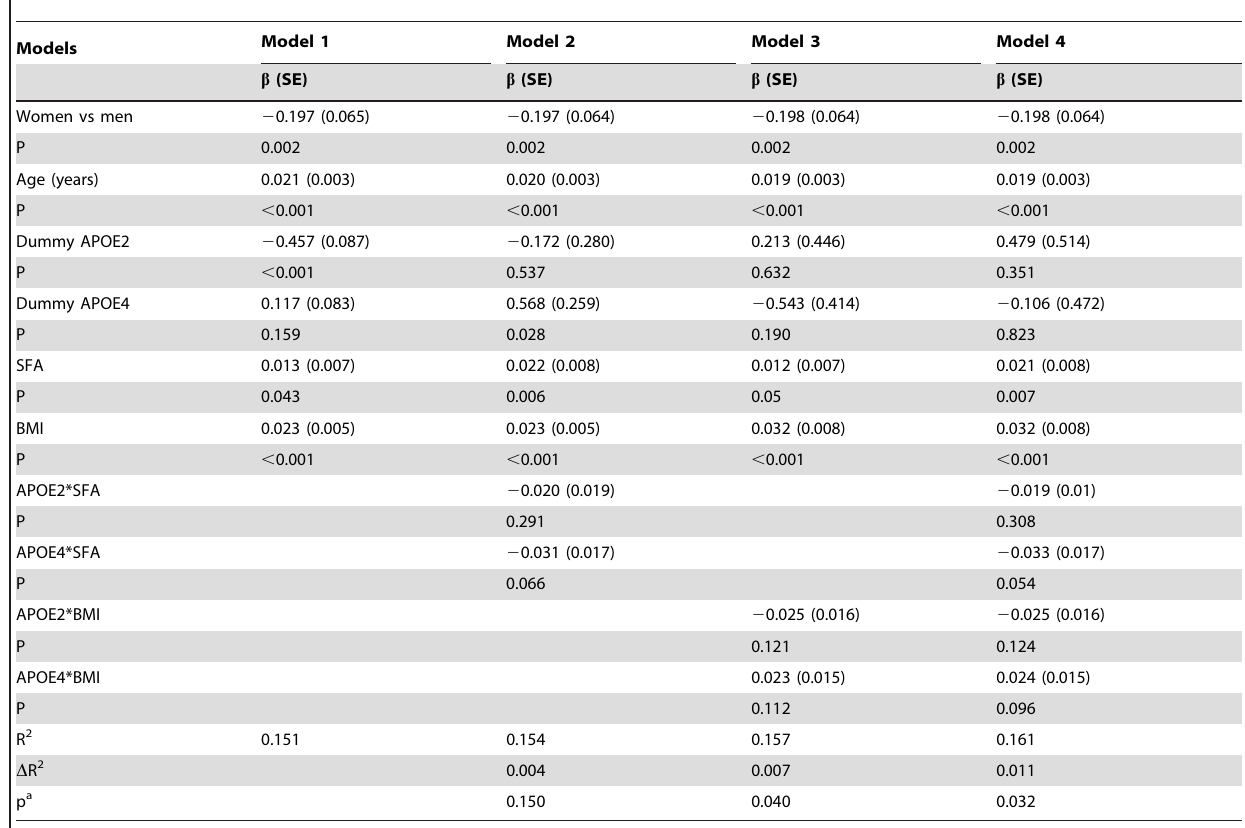
Table 6. Association of apolipoprotein E genotype, SFA intake, and BMI with low-density lipoprotein cholesterol.